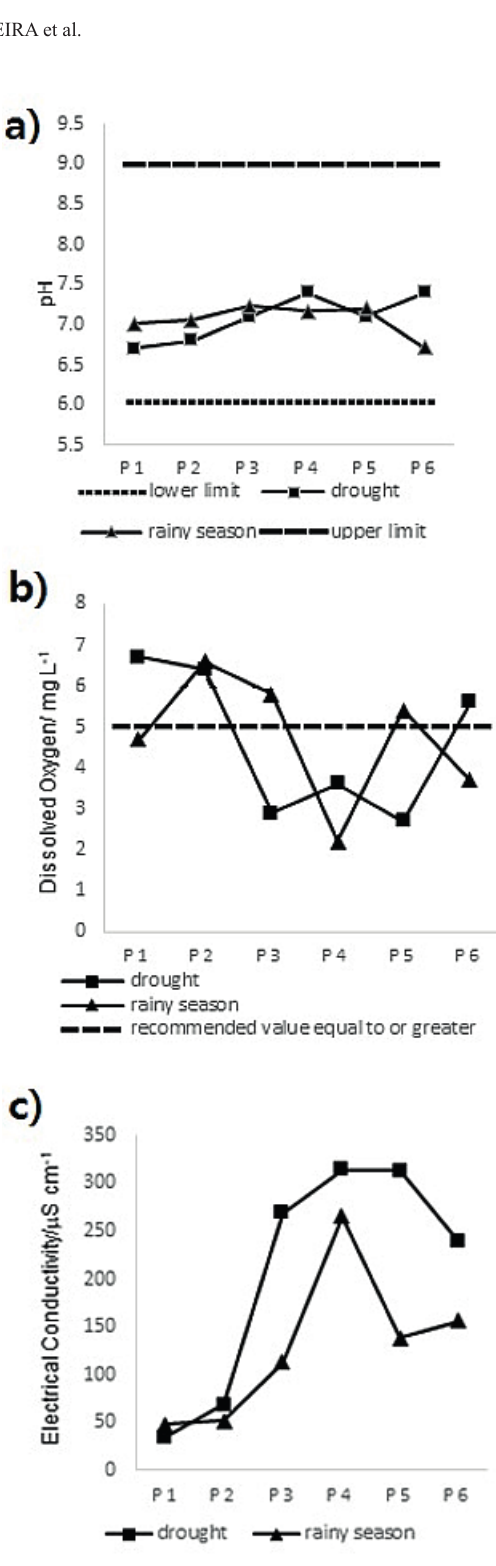
Figure 2 - Physical and chemical parameters: a ) pH, b ) dissolved oxygen, c ) electrical conductivity for the water samples from the Todos os Santos